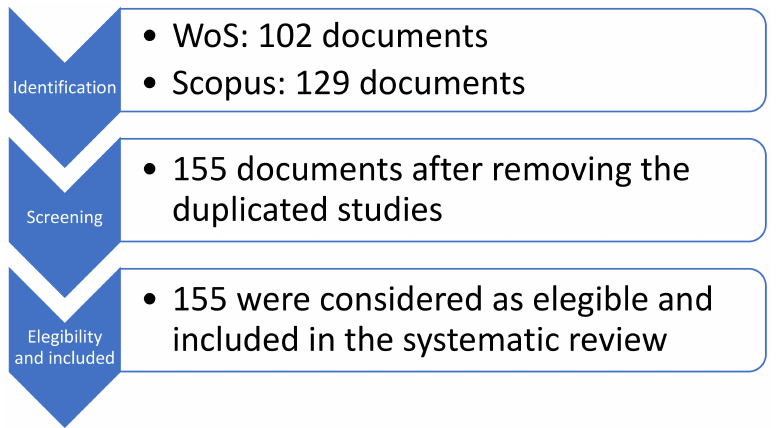
Figure 1. Steps to select the documents for systematic review, considering the PRISMA approach.